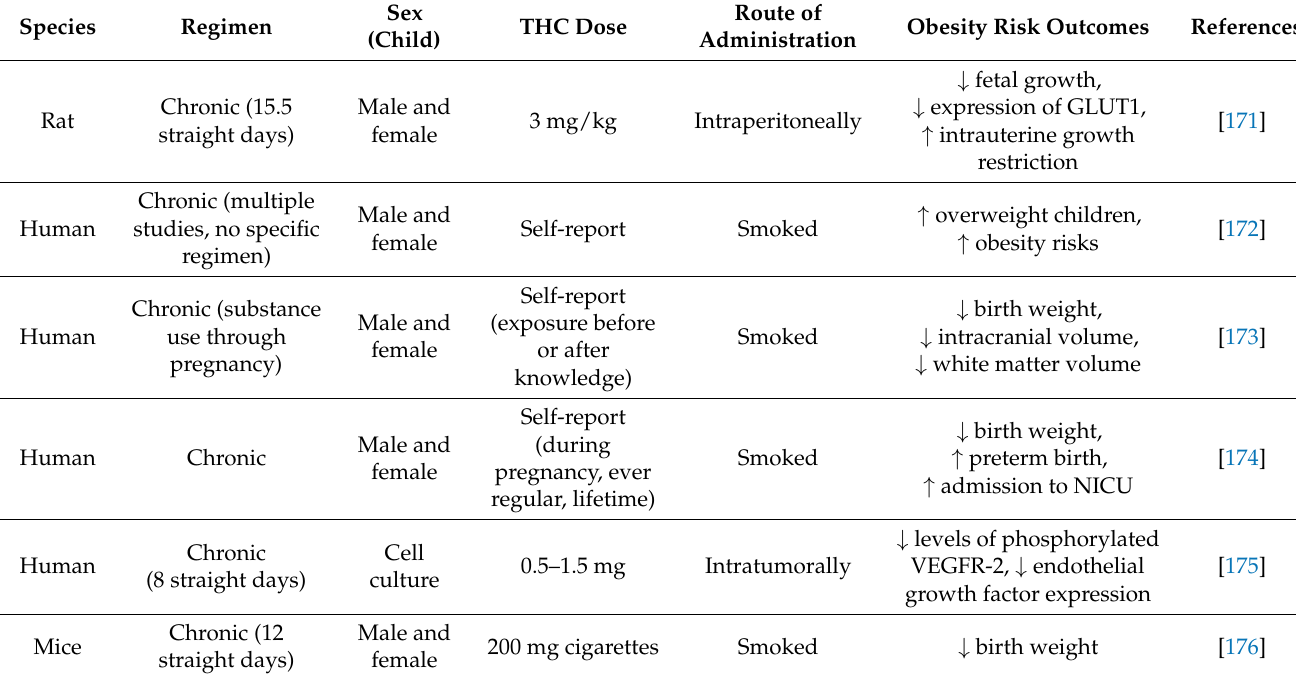
Table 3. A summary of preclinical and clinical trials that represent prenatal THC administration and the primary outcome that it had on inducing postnatal issues that can eventually lead to increased obesity risks later into the child’s adolescence, and even later in life. A majority of the obesity risk outcomes from the administration of THC were based on birth weight, but also levels of fetal stress during pregnancy. The limited information in certain sources resulted in some of the information that would have been contained within the table being